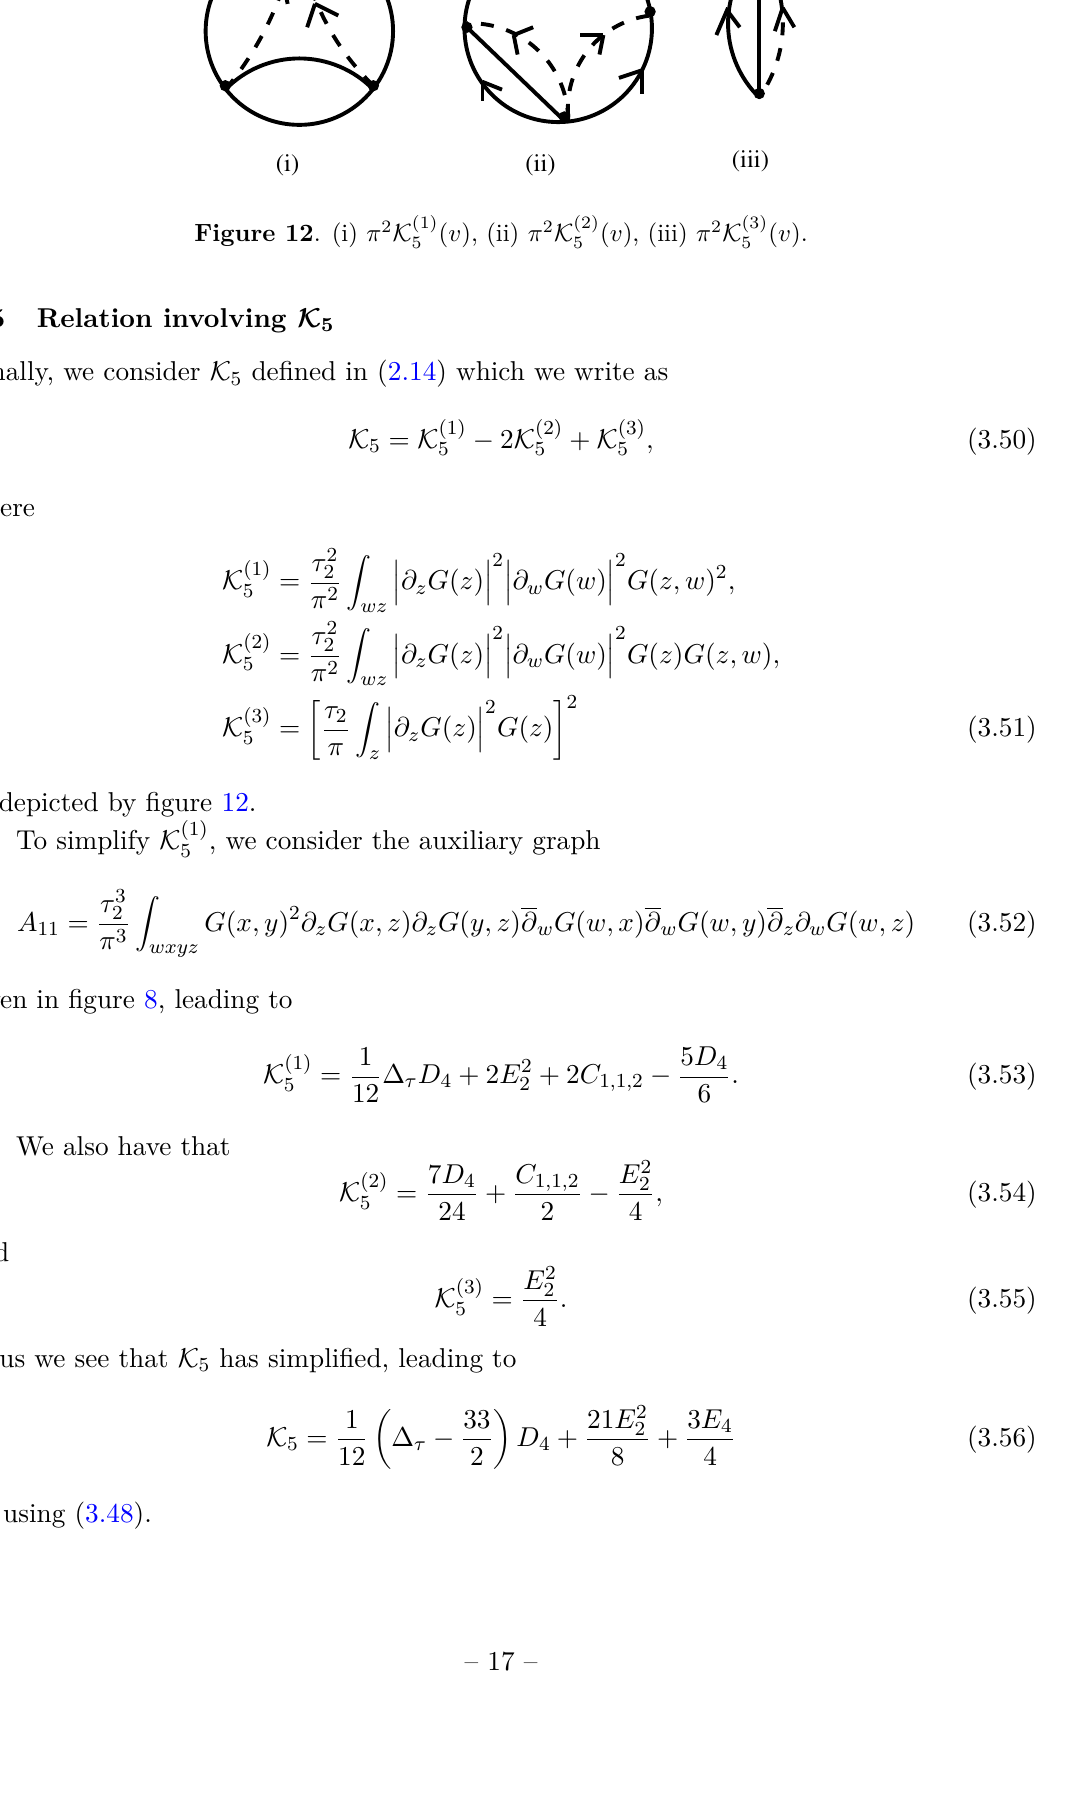
Figure 12 . (i) π 2 K (1)